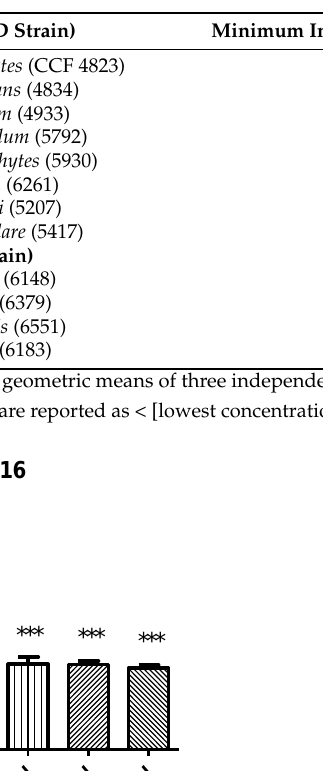
Table 6. Minimal inhibitory concentrations (MICs) of B. ferruginea methanolic extract against selected dermatophytes and yeasts.